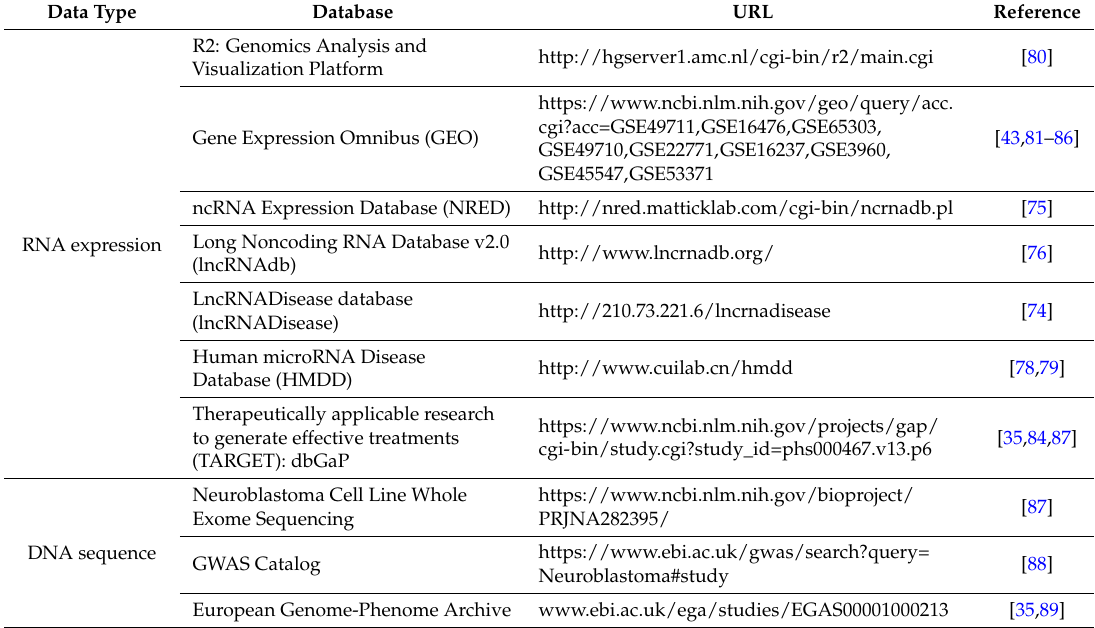
Table 2. A reference table of key resources for neuroblastoma big